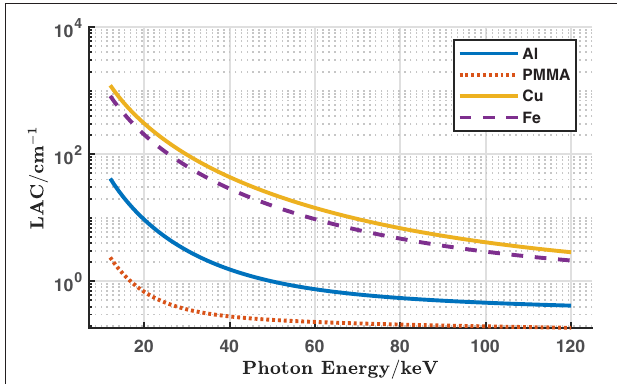
FIGURE 1 | Spectral linear attenuation coefficients of Al, PMMA, Cu, and Fe,